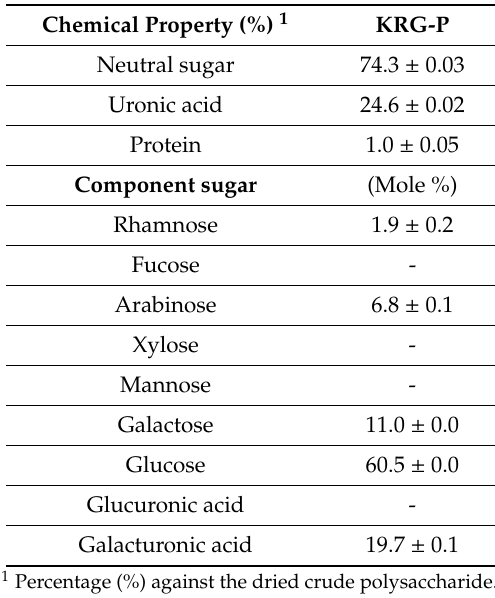
Table 3. Monosaccharide composition of KRG-P isolated from KRG-P.